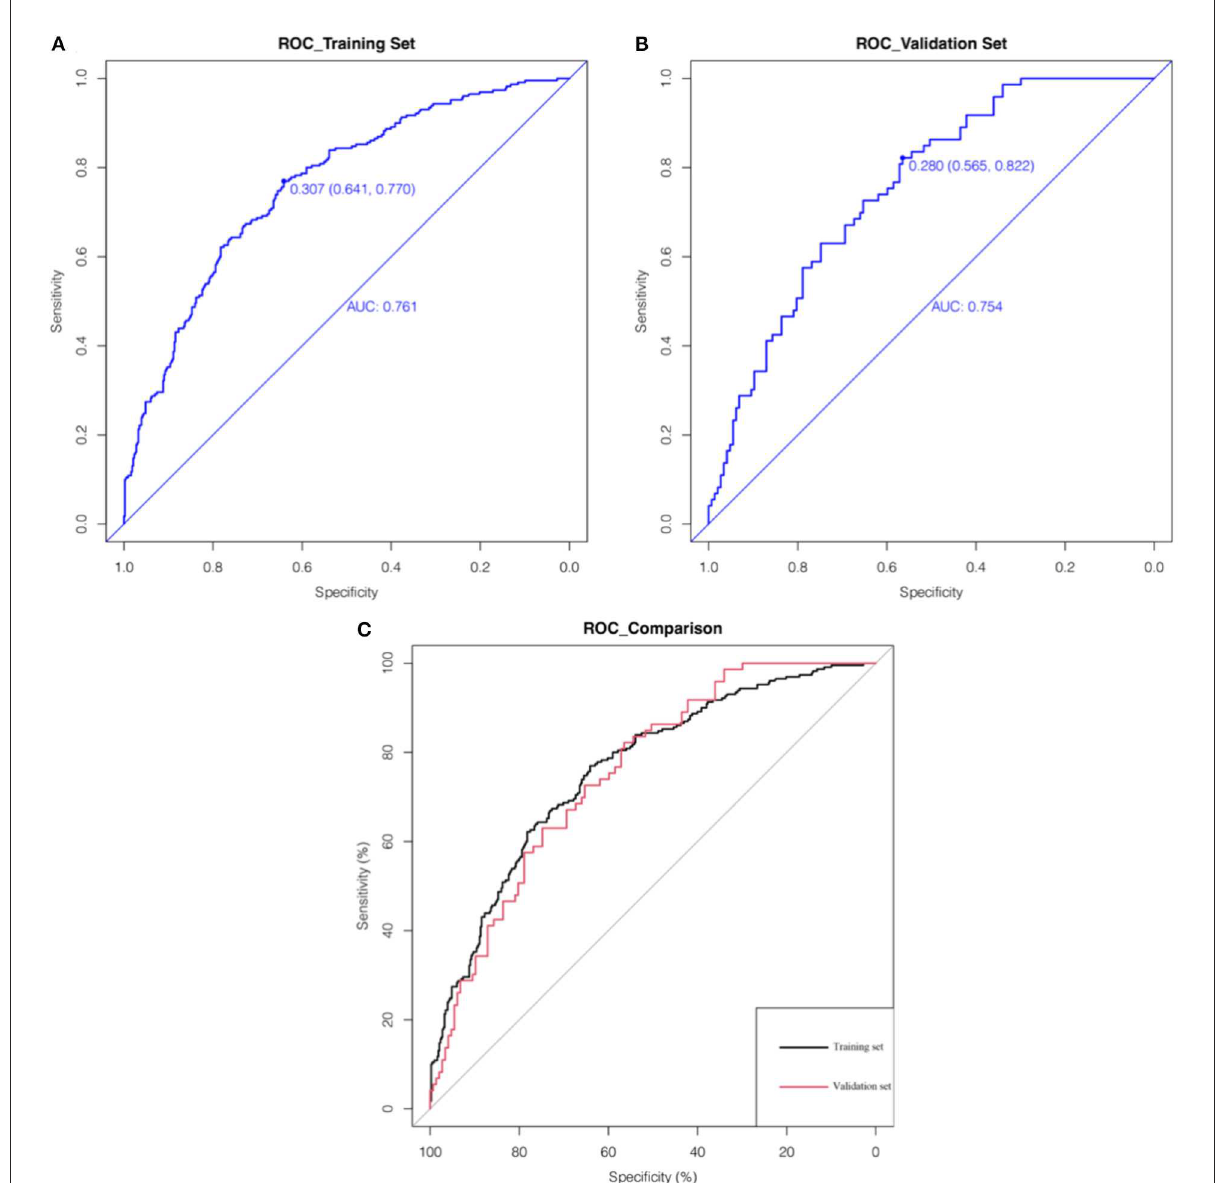
FIGURE3 The pooled AUC of the ROC curves in the training set and validation set. The x axis represents the true negative rate of the risk prediction. The y axis represents the true positive rate of the risk prediction. The thick blue line represents the performance of the nomogram in the training set (A) and validation set (B) . The (C) merges the ROC curves of the two sets together, where the thick black and red lines represent the ROC curves of the training set and validation set,